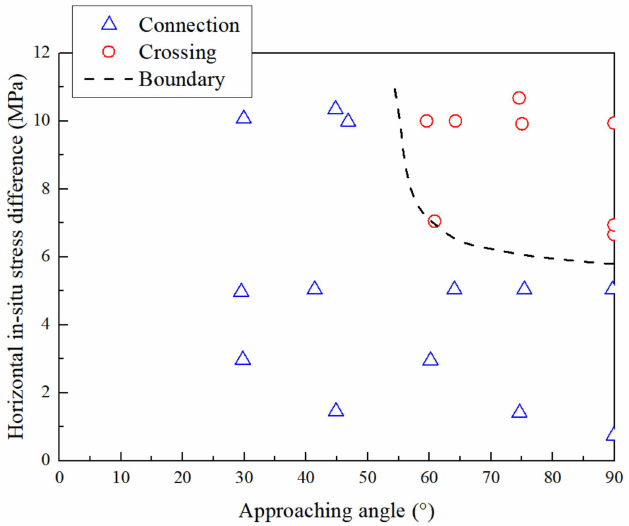
Figure 3. Influences of horizontal in situ stress difference and approaching angle on fracture propaga- tion. ‘Connection’ indicates that hydraulic fractures and natural fractures are interconnected, and natural fractures are ultimately extended by the intersected hydraulic fractures. ‘Crossing’ indicates that natural fractures are crossed by hydraulic fractures without